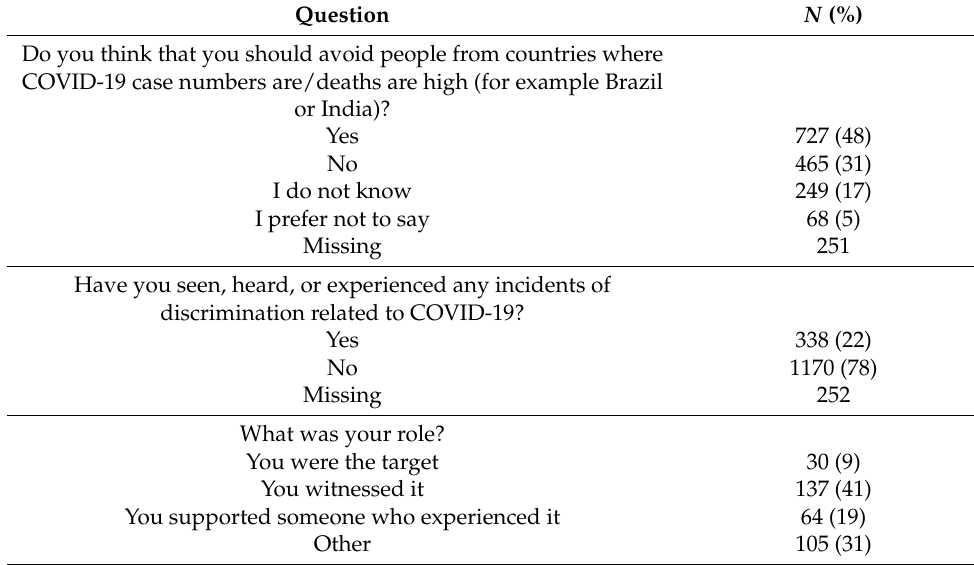
Table 10. COVID-19 and discrimination.